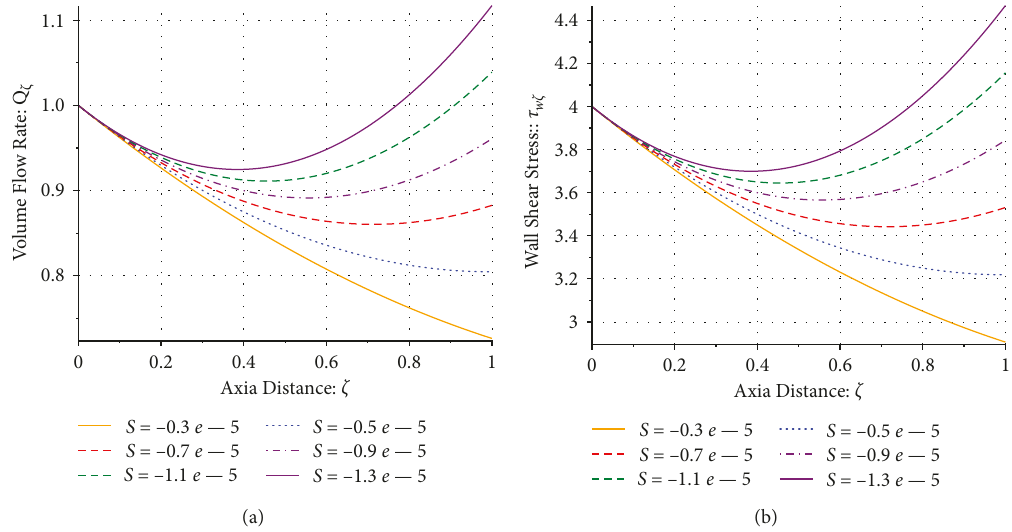
Figure 4: (a) Volume flow rate against ζ and (b) Wall shear stress against ζ for different values of linear absorption parameter S .